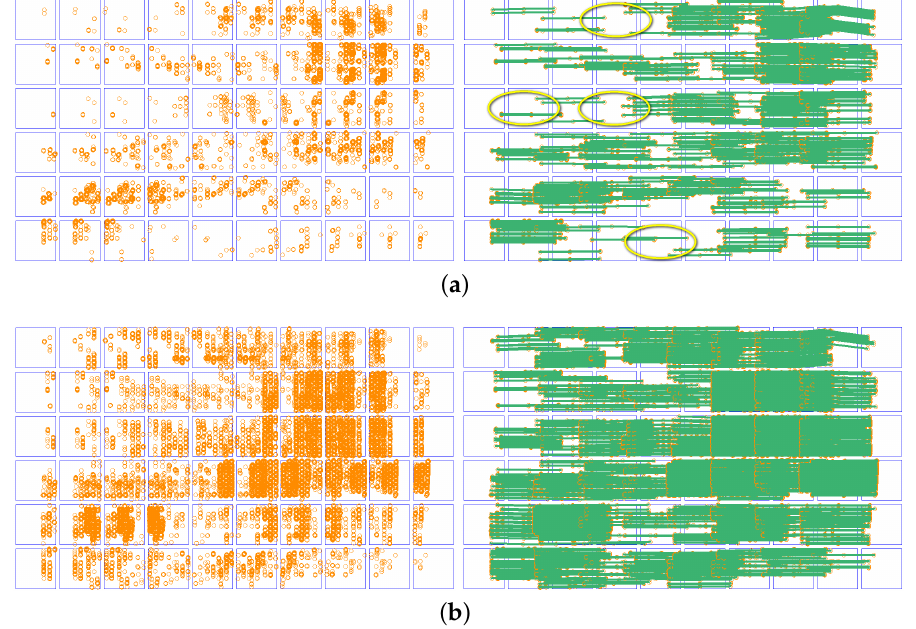
Figure 10. Show of forward image model tie points (orange circle). There are 0 or 1 model tie point in the yellow circle. ( a ) Block-SIFT (Left is model tie points and right is tie lines); ( b ) LR-SuperGlue (Left is model tie points and right is tie lines (green